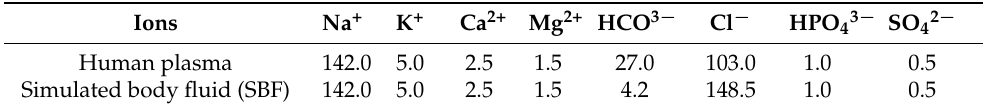
Table 1. The ion concentrations of SBF and human plasma